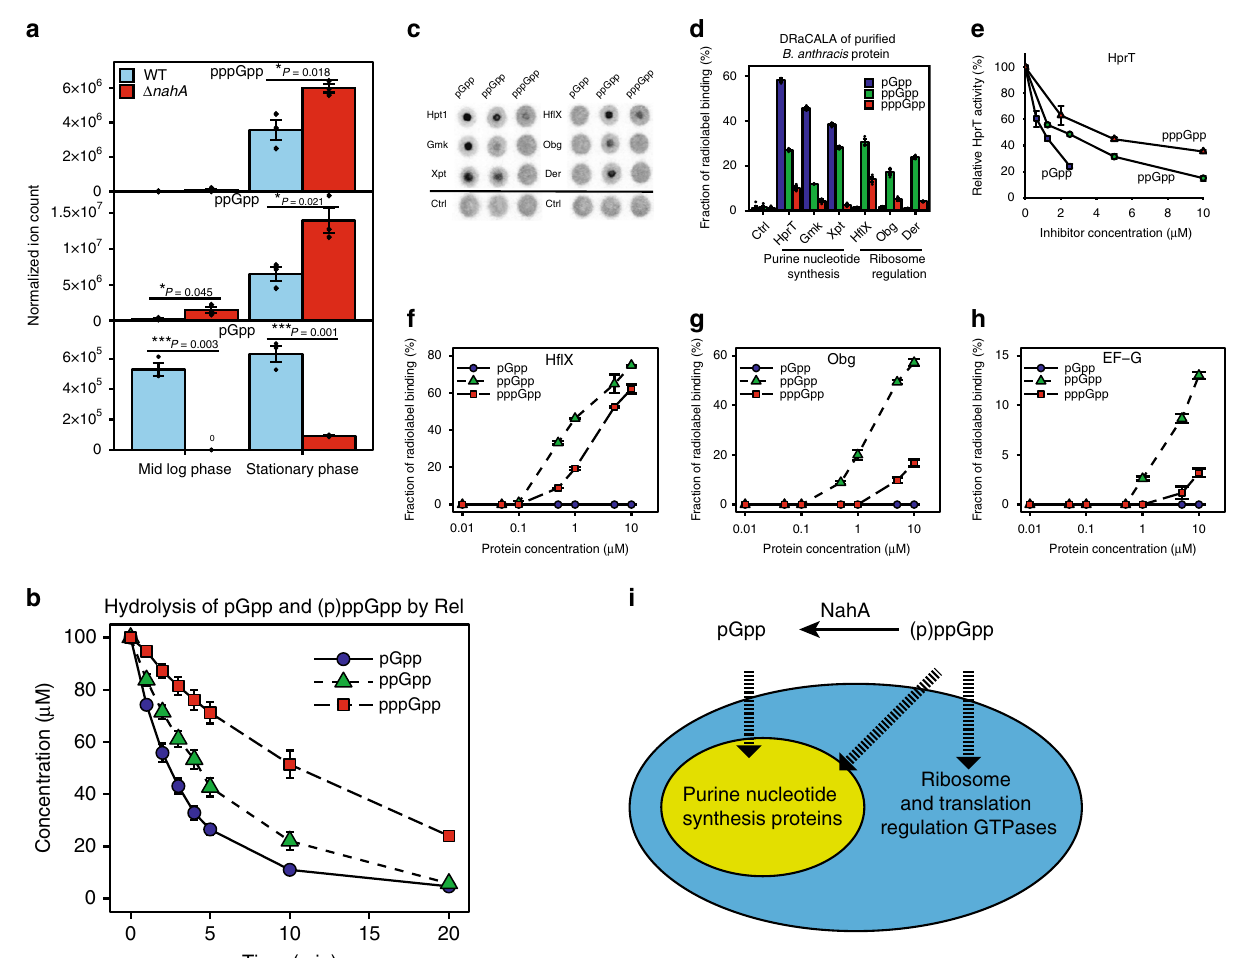
Fig. 3 pGpp is produced by NahA in vivo and has a distinct binding spectrum compared to (p)ppGpp. a LC-MS analyses of pGpp, ppGpp, and pppGpp of wild type and Δ nahA in log phase and stationary phase. Normalized ion count is ion count per OD 600nm per unit volume of the culture. Error bars represent standard errors of the mean of three biological replicates. A two-tailed two-sample equal-variance Student ’ s t test was performed between samples indicated by asterisks. Asterisks indicate statistical signi fi cance of differences (* P ≤ 0.05, ** P ≤ 0.01, *** P ≤ 0.001). b In vitro hydrolysis of pGpp, ppGpp, and pppGpp by B. subtilis Rel. For each nucleotide, 200 nM Rel was incubated with a mix of 100 μ M unlabeled alarmone and a small amount of 5 ′ - α - 32 P- labeled version. The degradation of the alarmone was analyzed by TLC to measure the decreased radioactivity. Error bars represent standard errors of the mean of three replicates. c DRaCALA of puri fi ed His-MBP-tagged B. anthracis proteins (1 μ M) with <0.1 nM of identical amount of 5 ′ - α - 32 P-labeled pGpp, ppGpp, and pppGpp. d Quanti fi cation of DRaCALA in c . Error bars represent standard errors of the mean of three replicates except for control group (six replicates). e HprT enzymatic activities in the presence of indicated concentrations of pGpp, ppGpp, and pppGpp. The reaction was performed with 20nM